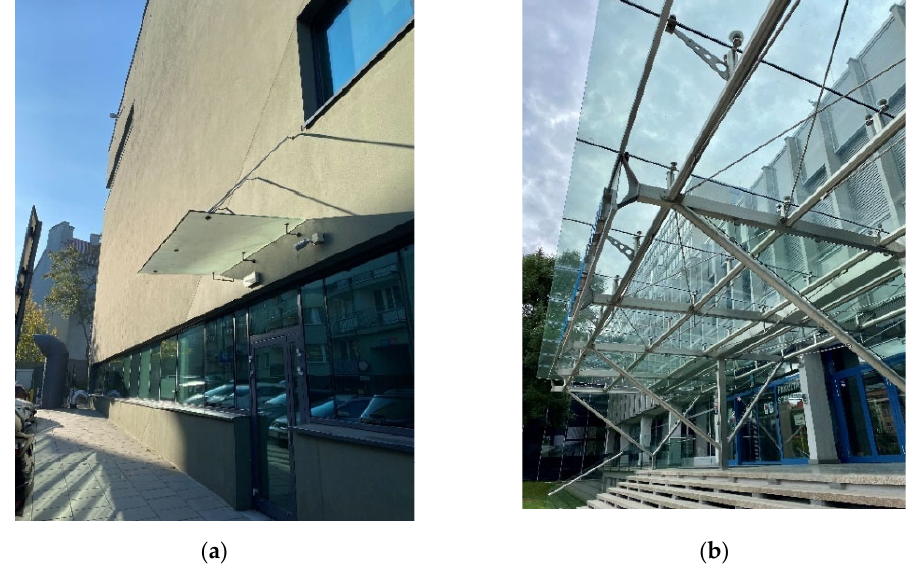
Figure 1. Examples of point ‐ fixed laminated glazing: ( a ) a canopy with fixing rods mounted above a building’s entrance; ( b ) glass infill panels mounted to a steel structure (pictures by M. Koz ł owski).